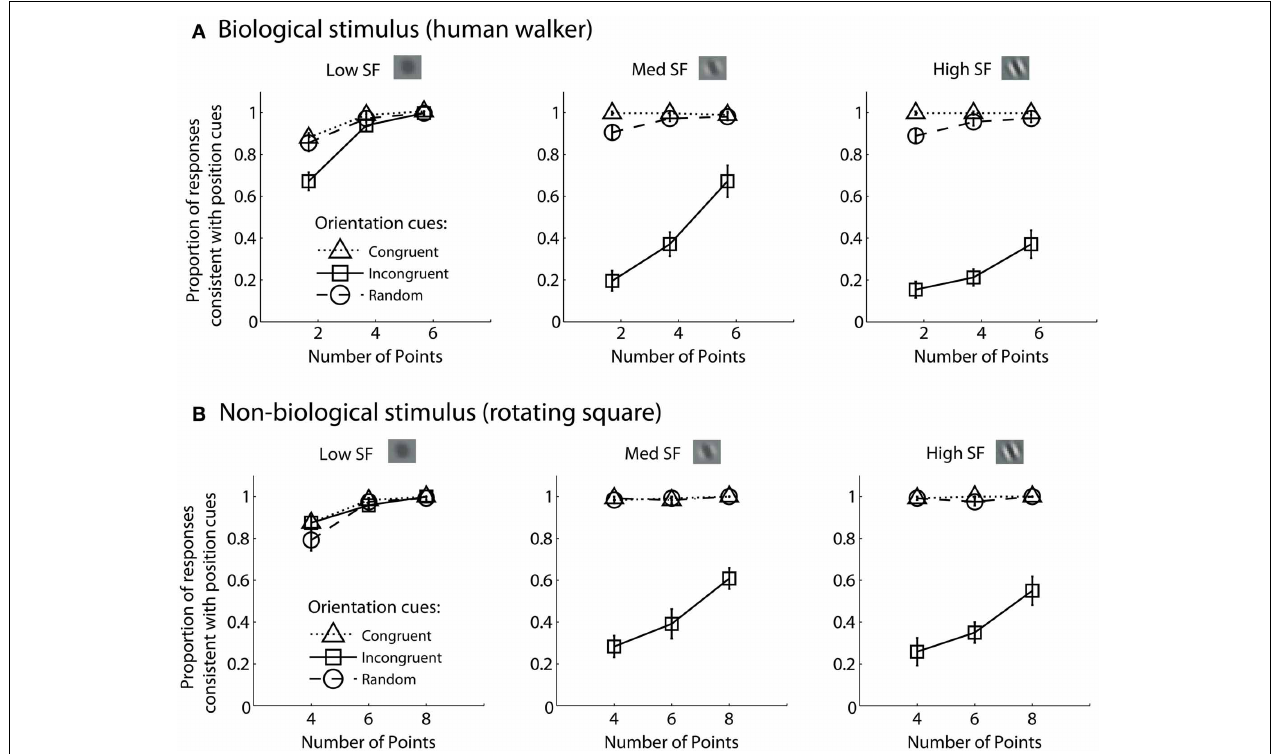
FIGURE 2 | Mean group data from Experiment 1 for biological (A) and non-biological (B) stimuli. The panels from left to right show the data from conditions with low, medium, and high spatial frequency elements, respectively. The x-axis represents the three conditions with varying numbers of sampled points per frame. The y-axis shows the proportion of responses